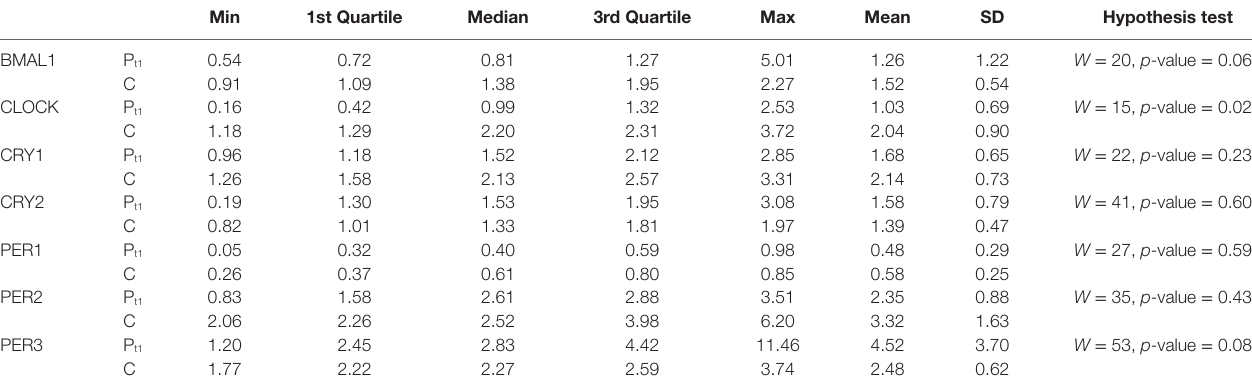
Only the CLOCK gene showed statistically significant changes.